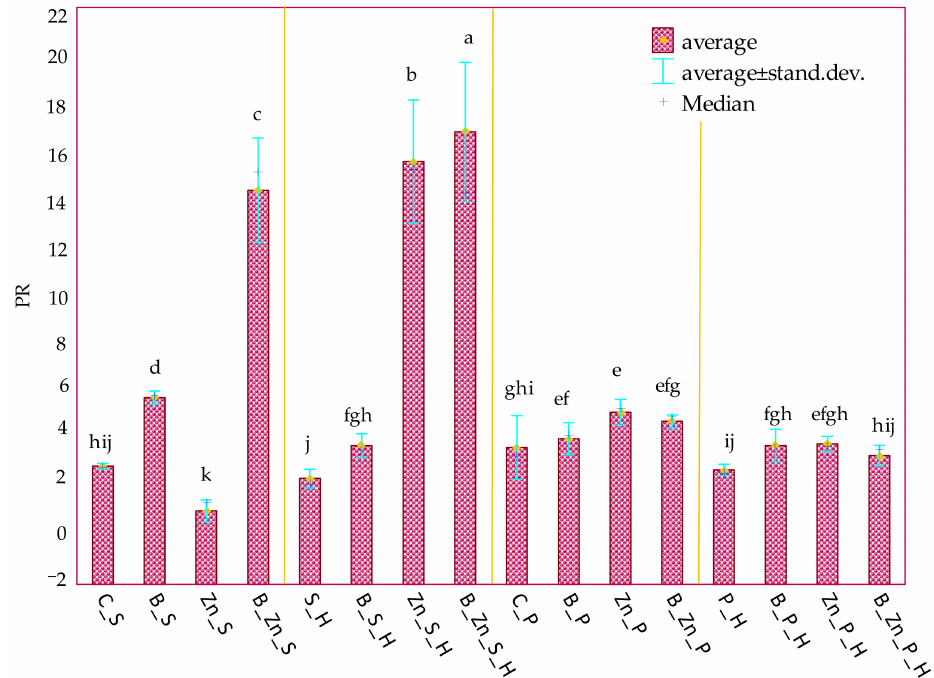
Figure 12. The ratio of the mass of the aerial parts of the plants to the roots (PR) in the soil contami- nated with B, Zn 2+ , B + Zn 2+ ; C—uncontaminated soil; S— Sorghum Moench ; P— Panicum virgatum ; H—humic acid; B—bisphenol A; Zn—ion zinc (Zn 2+ ). Homogeneous groups denoted with letters (a–k) were calculated for all PR ratio